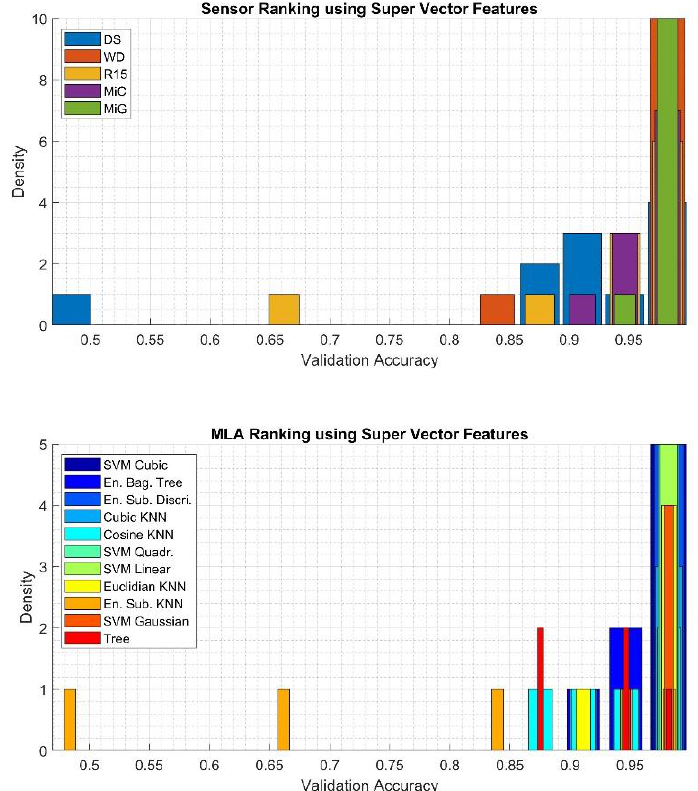
Figure 7. Very best validation accuracy values calculated for each of the algorithms and sensors depicted as a bar plot related to the Super Vector feature set.